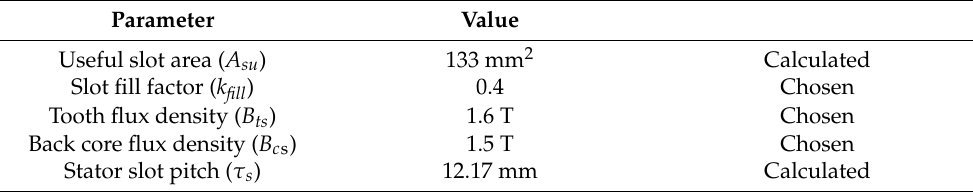
Table 4. Stator slot